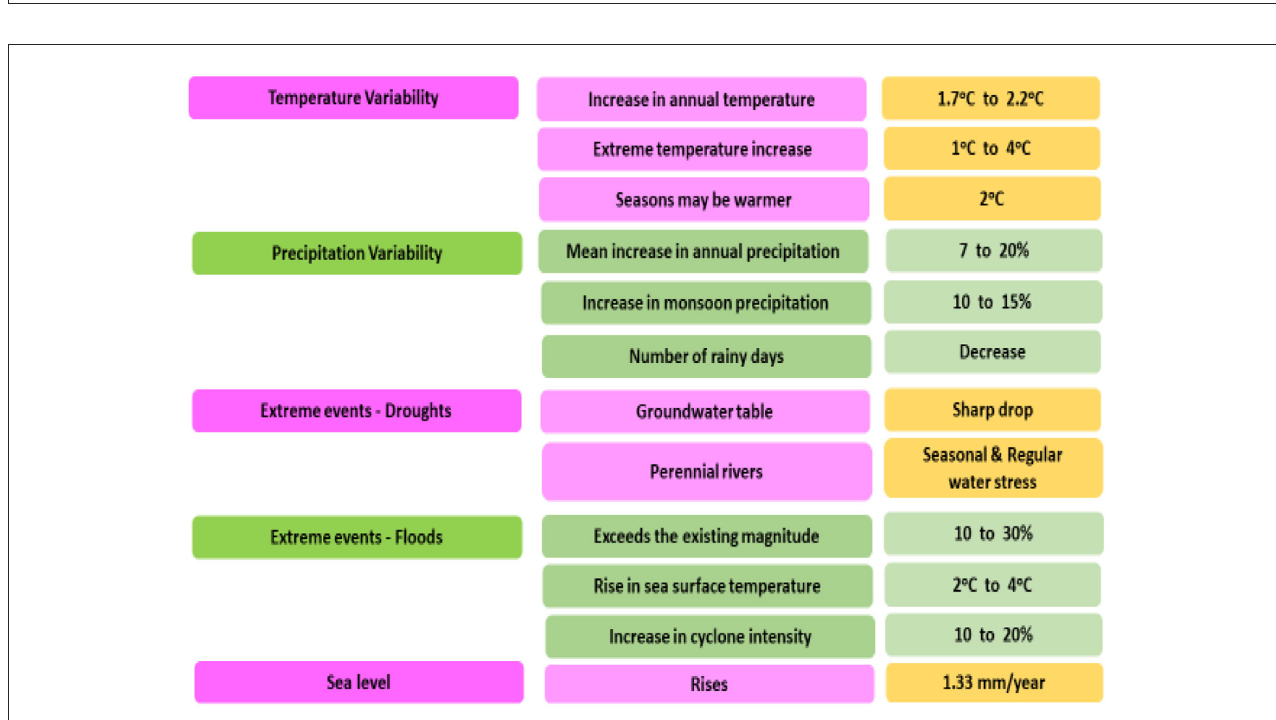
FIGURE2 Climate change projections for India by 2030 (compiled by Narain et al.,